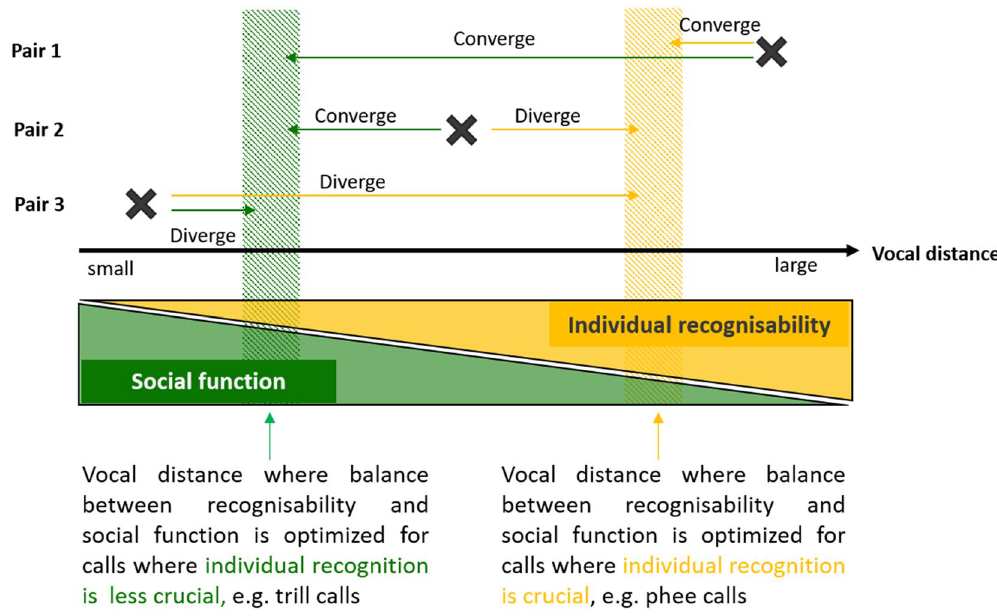
Figure 1. Schematic representation of the predicted trade-off between accommodation and individual recognisability. Depending on the initial vocal distance and call type, patterns of accommodation are expected to vary in different pairs, as exemplified by pair 1–3. Orange arrows indicate the amount and direction of accommodation in a pair for a call where individual recognition is crucial, green arrows for calls where individual recognition is less important. If animals are very similar (pair 3) or very different (pair 1) prior to pair formation, convergence or divergence might be found in any call type, but to a different degree. If a pair shows intermediate vocal distance (pair 2) the pattern of accommodation might vary depending on the call function. Coloured triangles at the bottom represent the amount of social function (green) or individual recognisability (orange) that can be represented in a call at any given vocal distance (black arrow) between two individuals. If individual recognition in a call is important, the optimal distance should be where individual recognition is still strong (orange arrow and orange shaded area). If individual recognition is less important, the optimal vocal distance is expected where the social function is making up a larger part (green arrow and green shaded